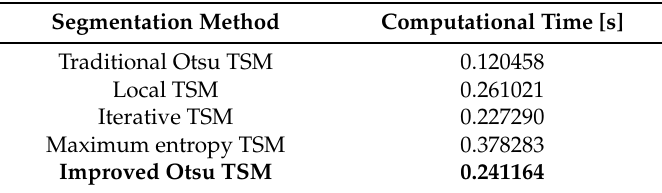
Table 6. Computational costs of different segmentation methods on Figure